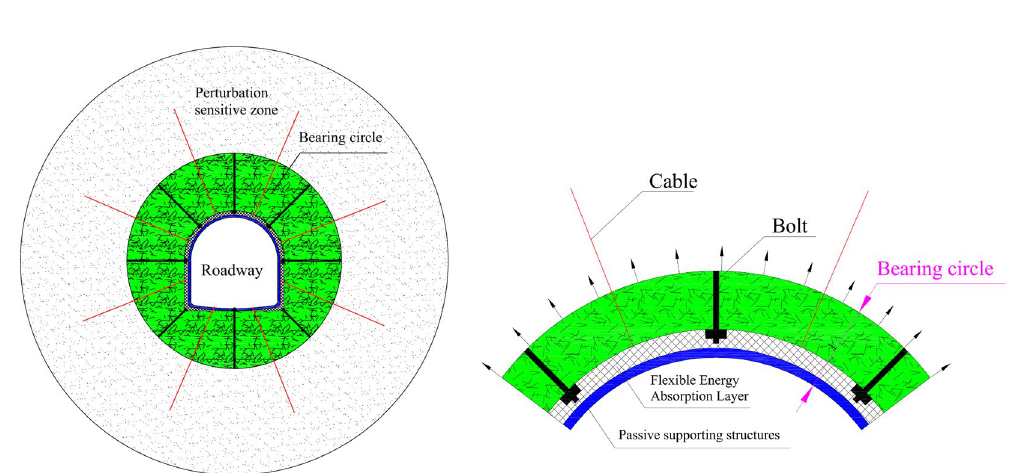
Figure 5. Structure of the surrounding rock “bearing